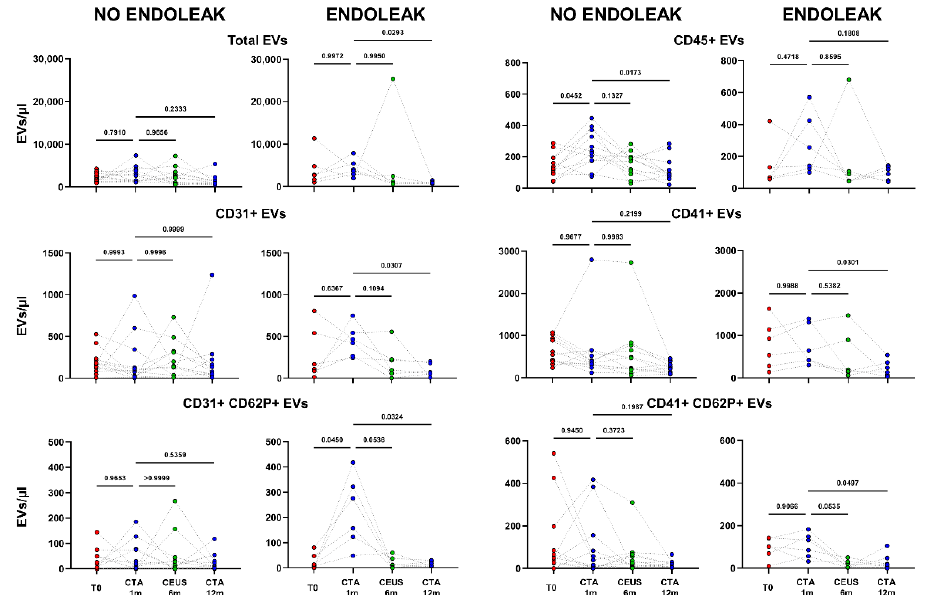
Figure 4. Dots represent numbers (EVs/ µ L) of EVs from peripheral blood of patients sorted into the category “No Endoleak” ( n = 12) and of “Endoleak” patients ( n = 6), analyzed at baseline (T0), and after 1, 6, and 12 months following EVAR intervention, as established in the diagnostic protocol. Each line connects the time points of a single donor. Repeated measures one-way ANOVA or a mixed-effects model was used to compare the means of the different time points. Dunnett’s multiple comparison test was used for multiple comparison.